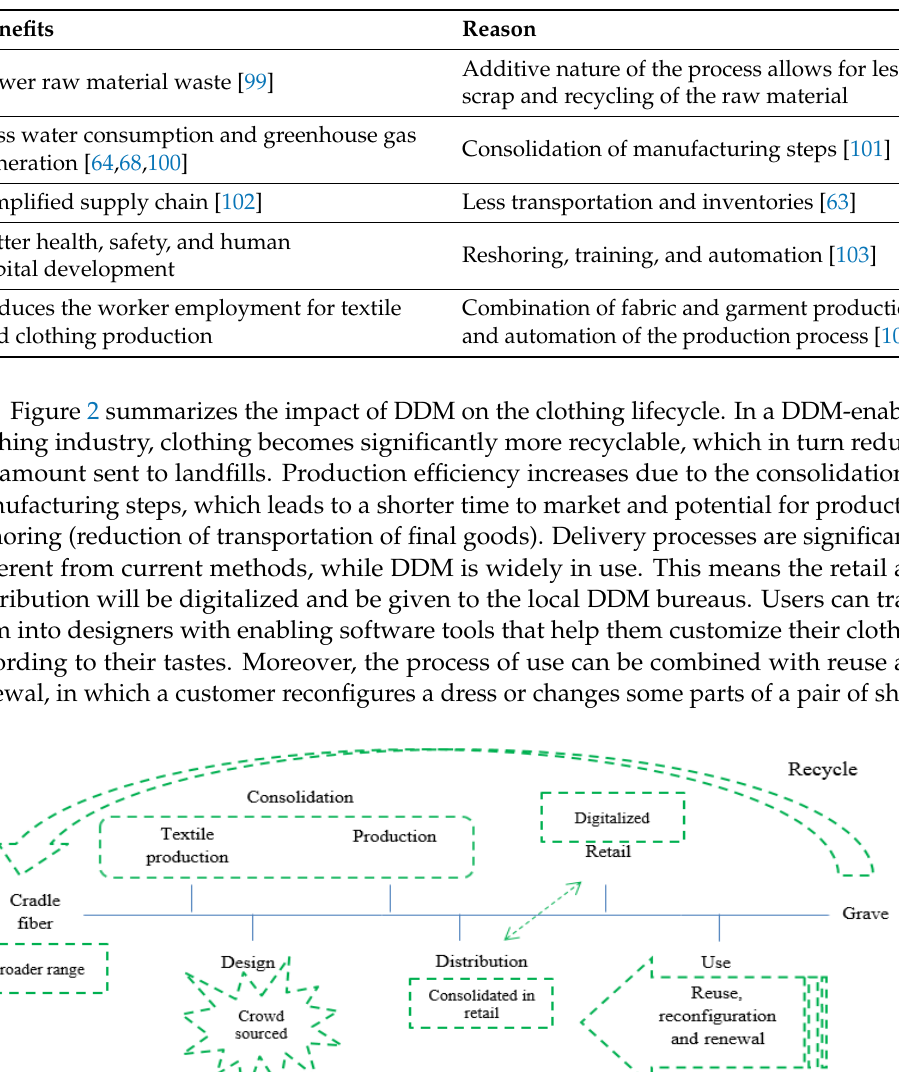
Table 2. The generic benefits of AM implementation in the fashion industry.